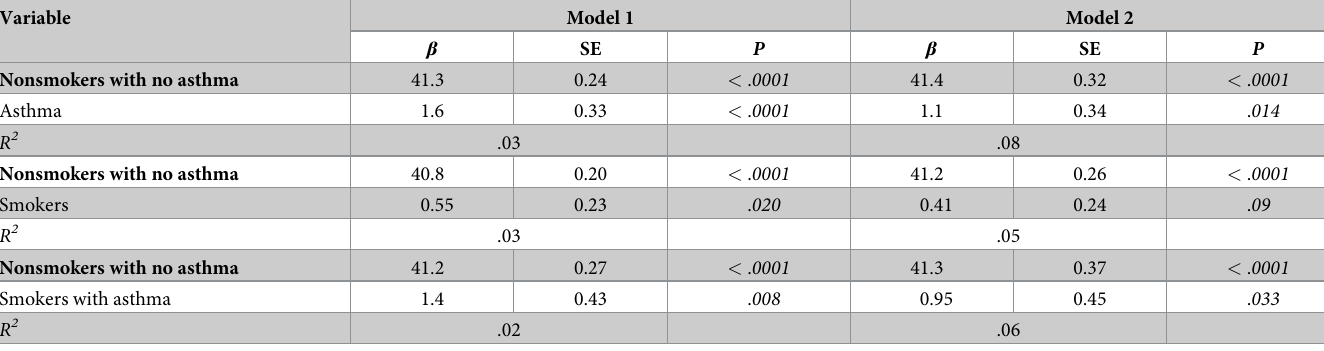
Table 3. Associations of asthma and smoking with waist circumference.